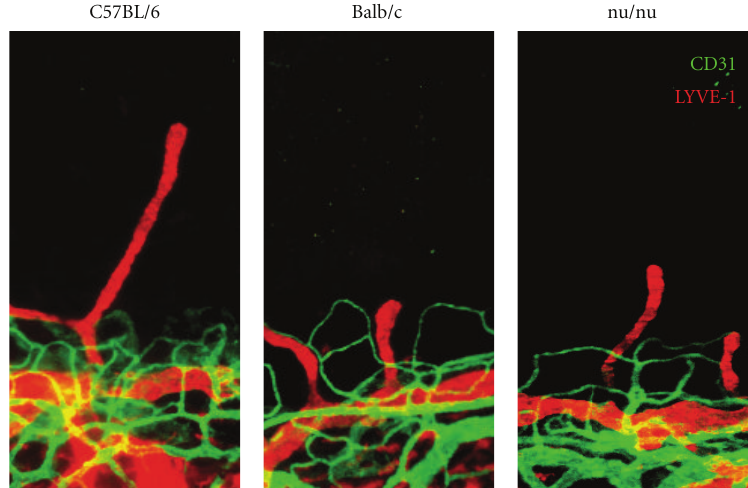
Figure 3: Strain-dependent limbal lymphatics. Genetic background significantly a ff ects corneal preexisting limbal lymphatics. The area of preexisting lymphatics in C57BL/6 mice is significantly larger than that in Balb/c mice. nu/nu mice show the intermediate phenotype. Preexisting limbal lymphatics may be heterogenic in patients, causing di ff erences in corneal transplant rejection or keratitis. nu/nu mice develop normal lymphatics, suggesting that T cells may not be important for lymphatic development. Table 2: Lymphatic-associated ocular diseases. The list shows several diseases of the eye that are related to lymphatics or lymphangiogenesis. Further investigation might provide evidence of the contribution of lymphatics or lymphangiogenesis in the other eye diseases. Eye diseases Possible role of lymphatics Reference Corneal transplant